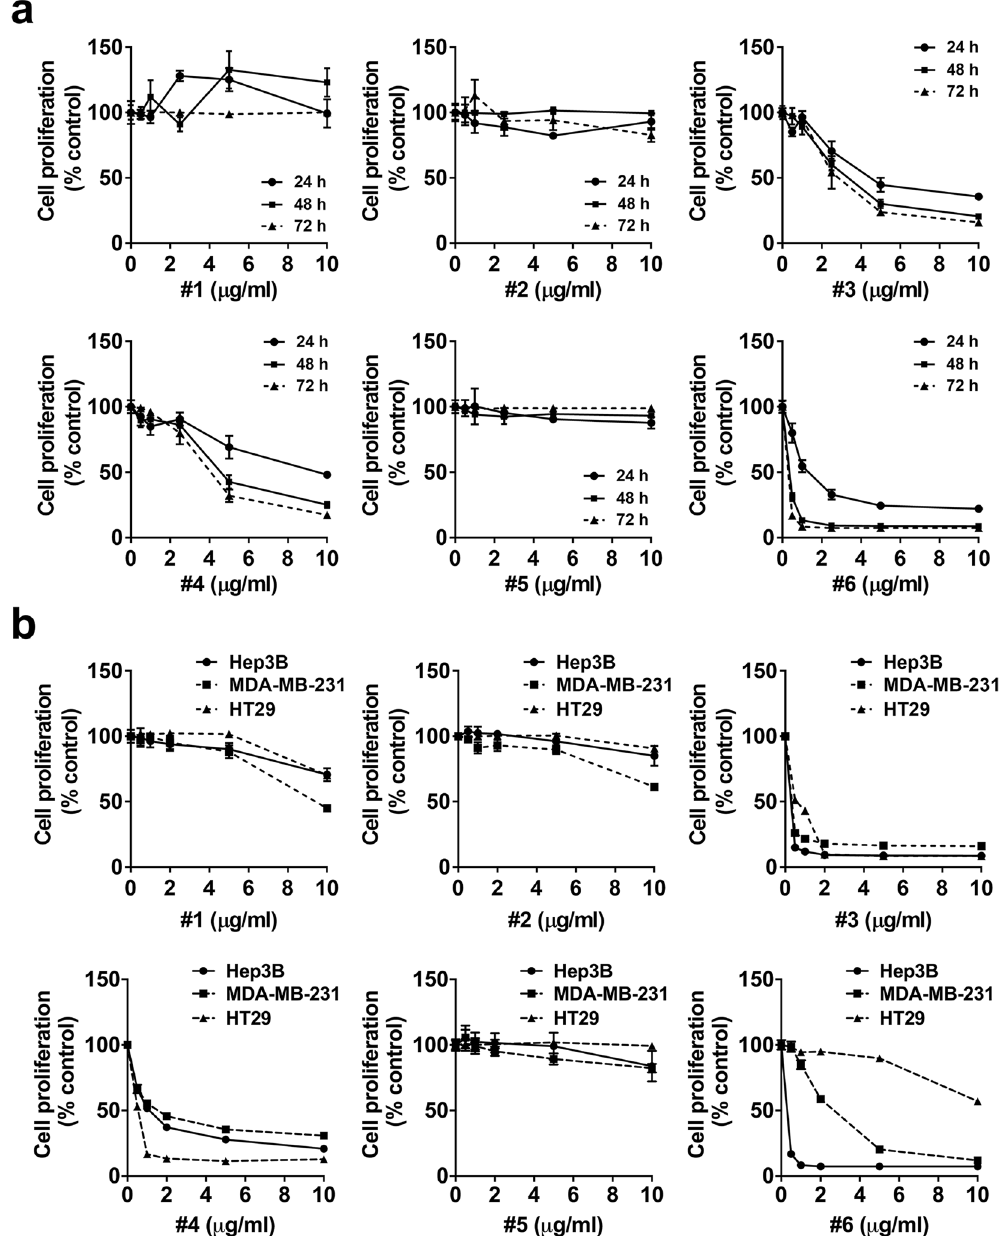
Figure 1. Screen of anticancer and radiosensitizing activity in the extracts of marine sponges collected from the Micronesian ocean. ( a ) Cytotoxicity of six marine sponge extracts were screened in human hepatocellular carcinoma Hep3B cells. Hep3B cells were incubated with either DMSO or the indicated concentrations of marine sponge extracts for 24, 48 and 72 h. Cytotoxicity was determined using a CCK-8 assay kit. Three of the samples had severe cytotoxicity in Hep3B cells. ( b ) Cytotoxicity of the six marine sponge extracts were compared in Hep3B, breast cancer MDA-MB-231, and colorectal cancer HT29 cells. The cells were incubated with the indicated concentrations of the sponge extracts for 72